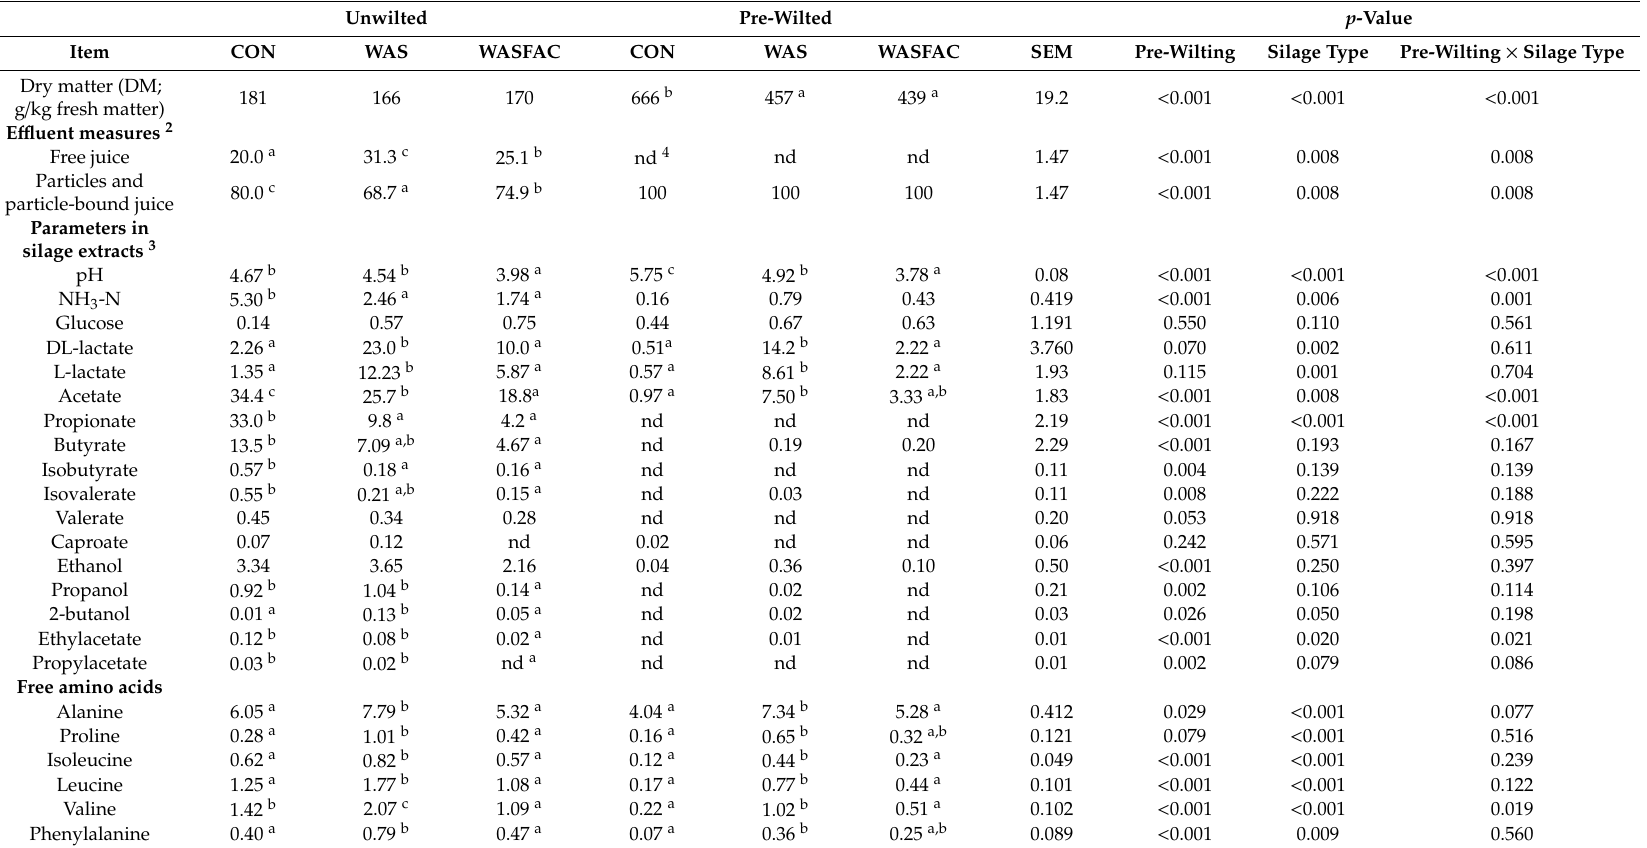
Table 2. Characteristics of Porphyra umbilicalis silages 1